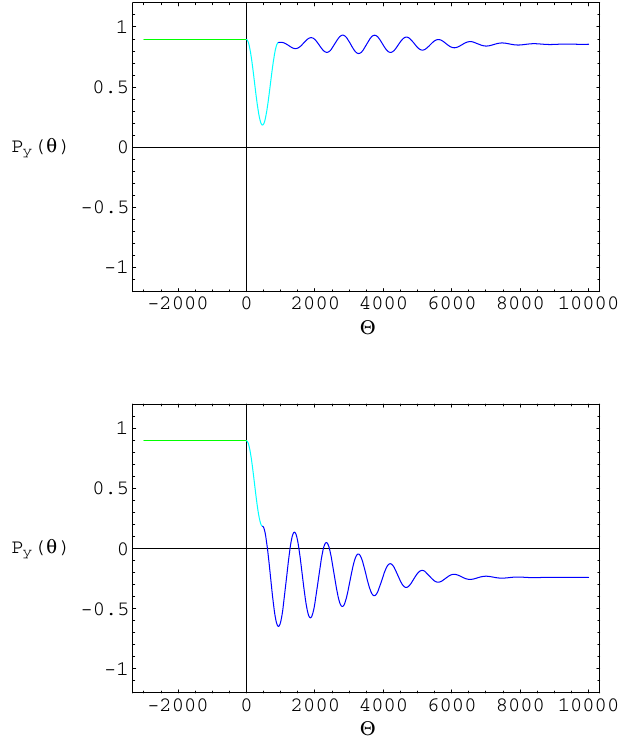
FIG. 7. (Color) Expected polarization in an interference-overlap experiment. The upper figure is when the two resonance cross- ings interfere destructively. The lower figure is when they interfere